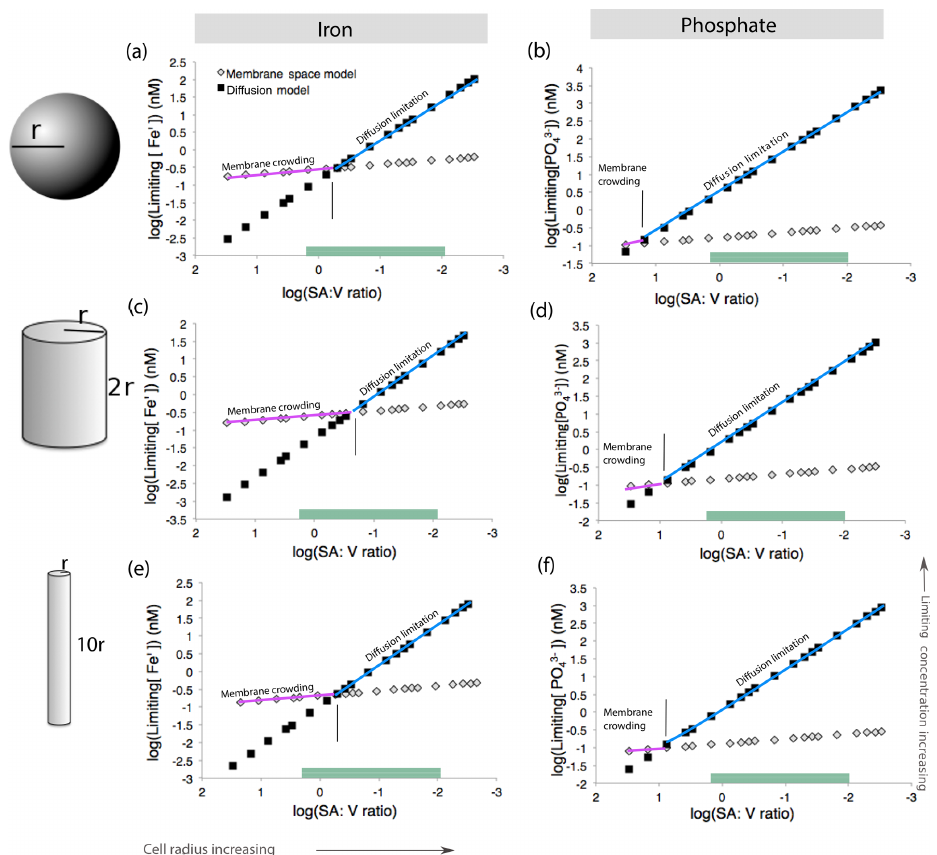
Figure 7. Model calculations for membrane space and diffusion-based nutrient limitation reveal that membrane crowding could drive Tri- chodesmium to iron or phosphate stress, particularly when cells are small. Two cell morphologies (sphere and cylinder) were modeled for both iron and phosphate limitation. Calculations are detailed in Table S10. As the cell radius increases and the surface area:volume quotient decreases, the limiting concentration increases. This is concurrent with the current understanding that the low surface area:volume quotient of large cells leads to limitation. Green bars represent common SA: V quotients for T. theibautii (Hynes et al., 2012) (a–b) . Membrane crowding (purple) occurs if the limiting nutrient concentration is greater than in the diffusion limitation model (blue). Membrane crowding is more significant for cylindrical cells in particular (c–d) ; altering the length of the cylinder minimally affects the model (e–f)